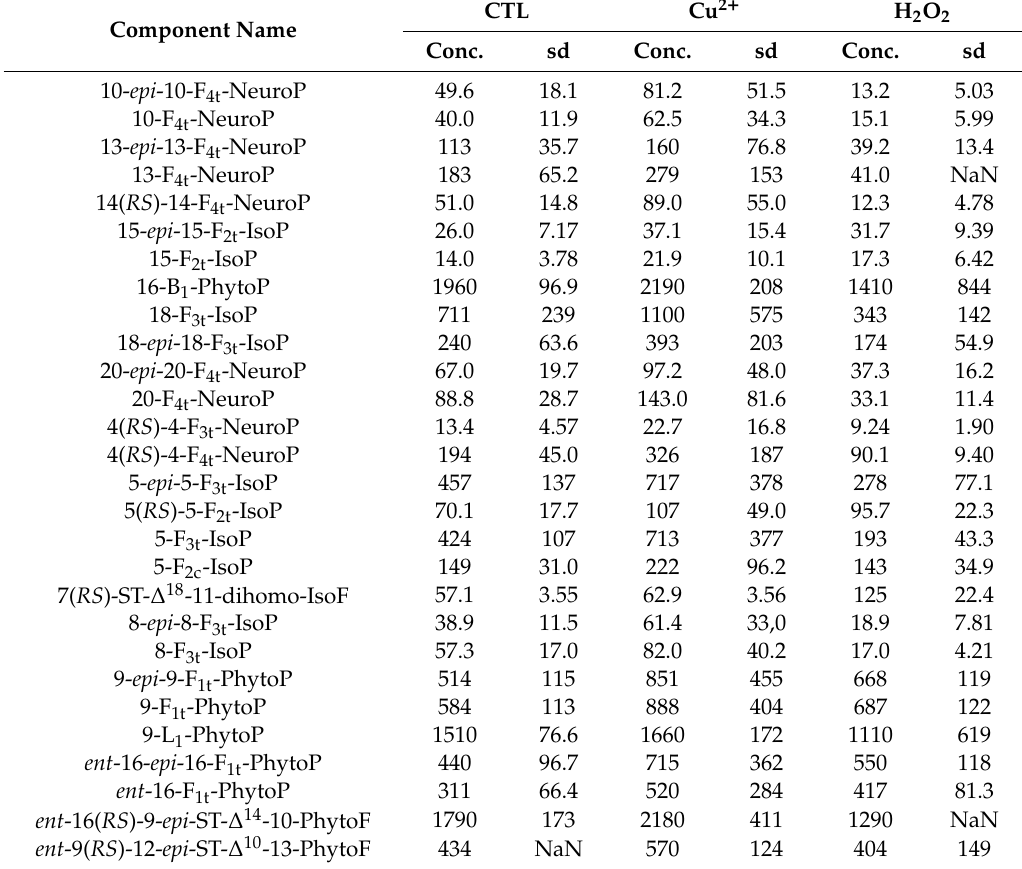
Table 2. Quantification of NEO-PUFAs in R. salina incubated under control, copper or H 2 O 2 stress conditions. Data are mean ± sd (n = 3) expressed as ng / g dry weight. NaN stands for Not a Number, because it is an impossible